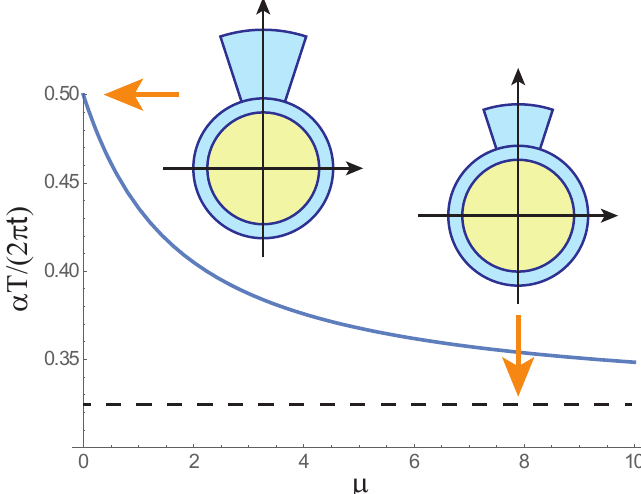
Figure 4. Optimal parameter u = α T / ( 2 π t ) of thin pneumatic actuator as function of pressure dependent structural parameter µ = ( P / E )( R / t ) . Insets show optimal cross-sections of actuator with α = π /5 for µ = 0 and µ (cid:29)